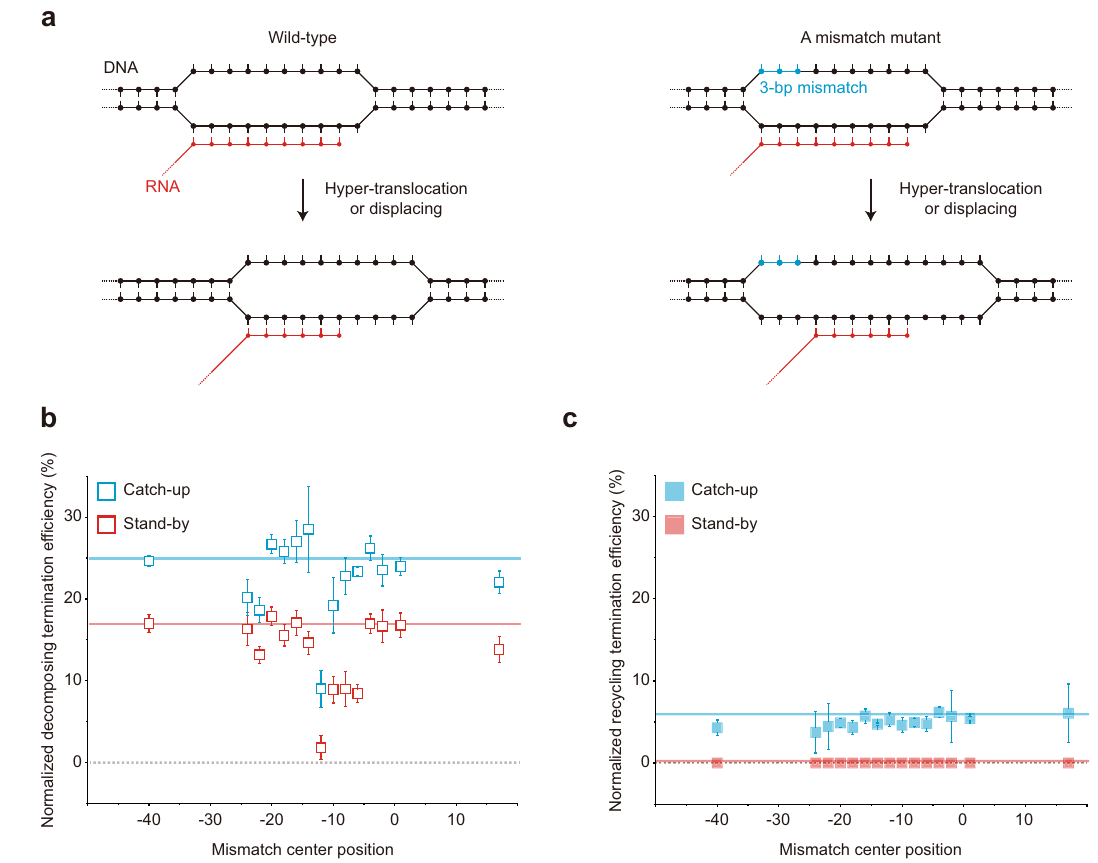
Fig. 6 RNAP displacing resulting only in EC decomposing. For RNAP displacing tests, comparisons were made among 15 DNA templates with a 3-bp mismatch. ρ -dependent TEs ( = raw TE — background TE) of recycling (solid) and decomposing (open) were measured in stand-by (red) and catch-up (cyan) assays and normalized to the maximum of 100% by dividing with (1 — background TE). a Putative elongation-coupled progression of transcription bubble in the mgtA wild-type template and a mutant with a 3-bp mismatch (blue). b A peaked effect of the 3-bp mismatch on decomposing termination. Normalized decomposing TEs of the 15 mutants in the y -axis are plotted against the center position of the 3-bp mismatch in the x -axis. Horizontal lines indicate the values of the wild-type template (16.7% for stand-by assay and 24.9% for catch-up assay). c No effect of the mismatch on recycling termination. Normalized recycling TEs in the y -axis are plotted against the mismatch position in the x -axis. Error bar represents the standard deviation of the mean from n ≥ 3 independent experiments. The numbers of analyzed molecules for ( b ) and ( c ) are in Supplementary Table 2. Source Data fi le includes the data for ( b ) and ( c